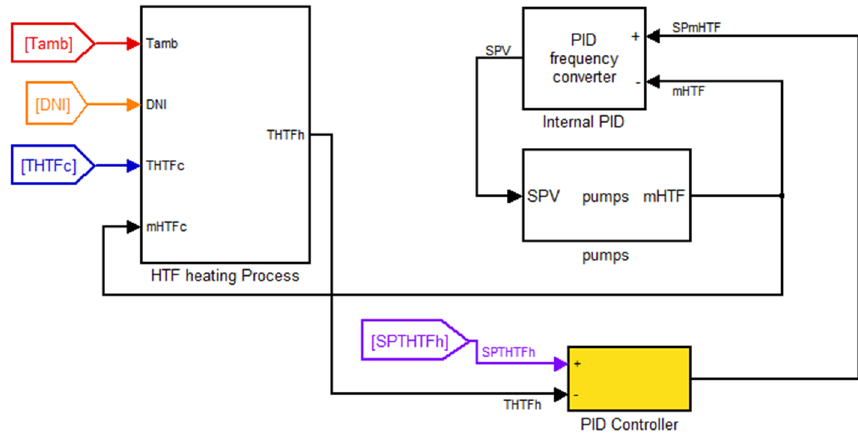
Figure 17. MatLab ‐ Simulink model of the PID control for the HTF ‐ heating process.